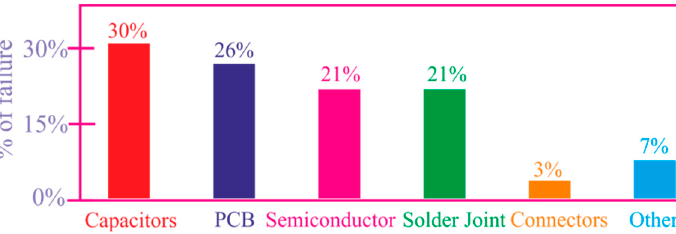
Figure 2. Distribution of faults in power electronic converters [14].